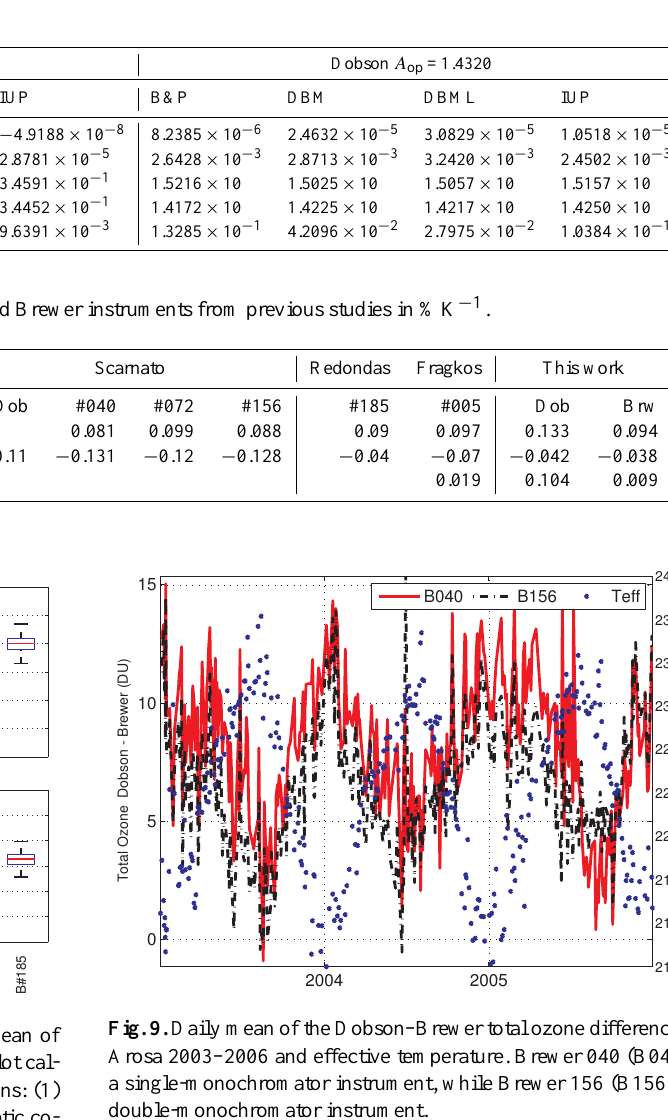
Table 7. Quadratic coefficient of the ozone absorption coefficient (C 2 ...C 0 ) , the absorption coefficient for the operative temperature A o and the percentage gradient 1 for the three ozone cross sections calculated for Dobson and Brewer instruments. The operative value is also indicated (A op ) .